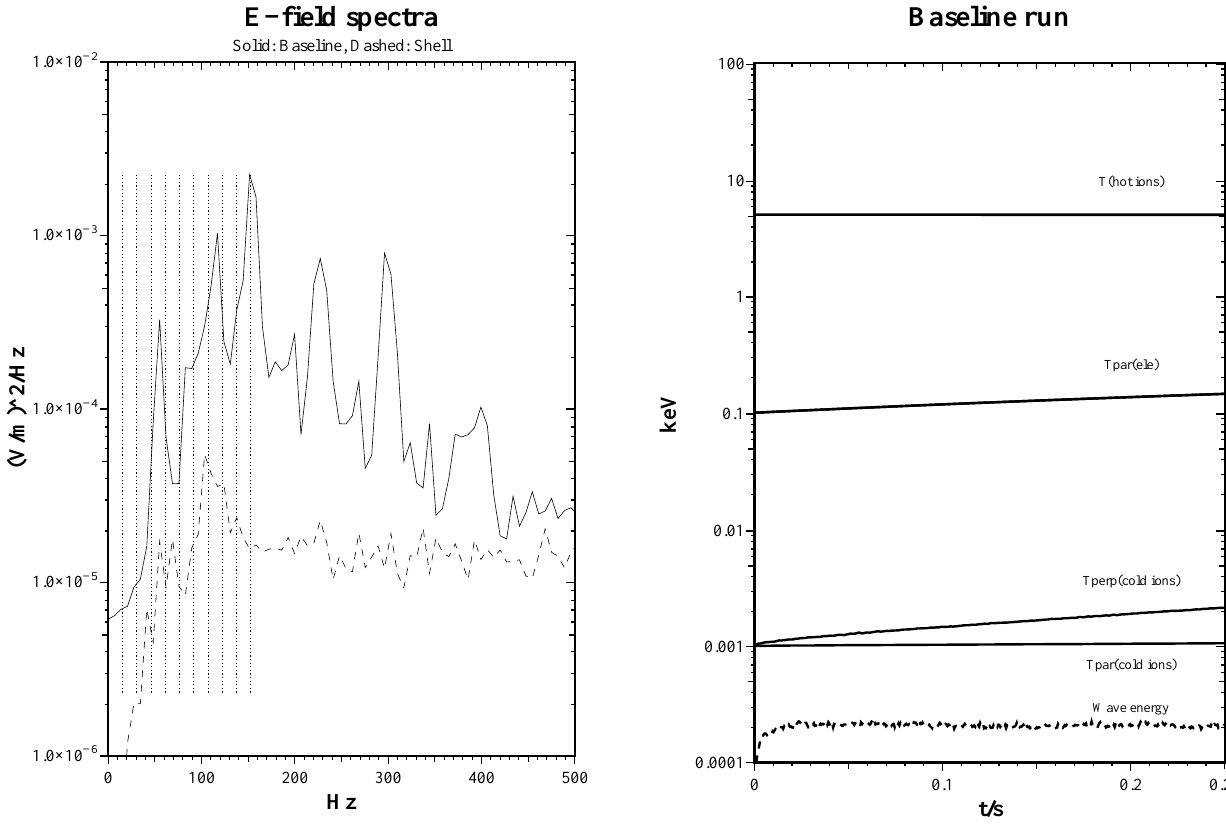
Fig. 12. Energy history of the baseline run. The parallel and per- pendicular temperature of various plasma populations are marked in the figure. The electrostatic energy per electron is shown by dashed